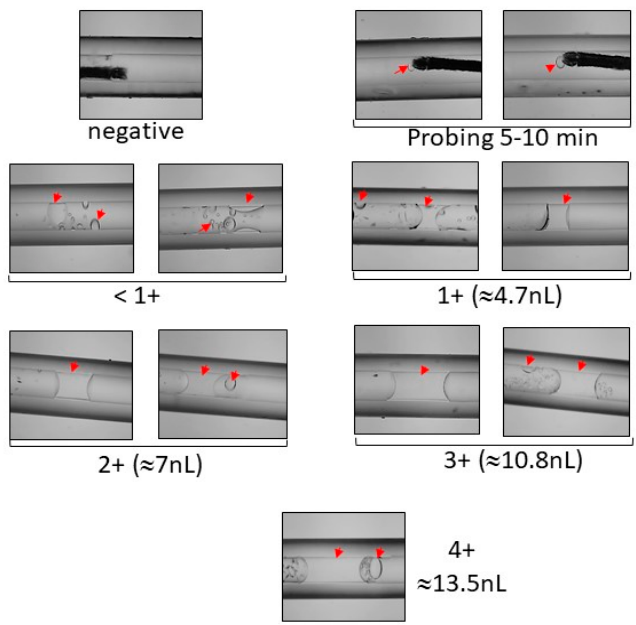
Figure 2. Individual capillaries observed under the microscope for the presence of saliva and assigned saliva categories based on total volume. The volume of saliva was calculated using the cylinder volume formula (V = π (r2 × h) = 3.1416 × 0.01 × h = mm 3 or µL) and measuring the height of the saliva with a digital fractional caliper (precision: ±0.02 mm), as described previously. The proboscis was removed from the capillary, and oil containing the saliva was expelled under pressure into 1.5 mL tubes containing 300 µL Dulbecco’s Modified Eagle Medium (DMEM supplemented with 20% of heat inactivated FBS, 1% penicillin/ strepto- mycin, 1% glutamine, 1% non-essential amino acids) and frozen immediately on dry ice. DMEM medium (7% heat inactivated FBS, 1% penicillin/streptomycin, 1% glutamine,